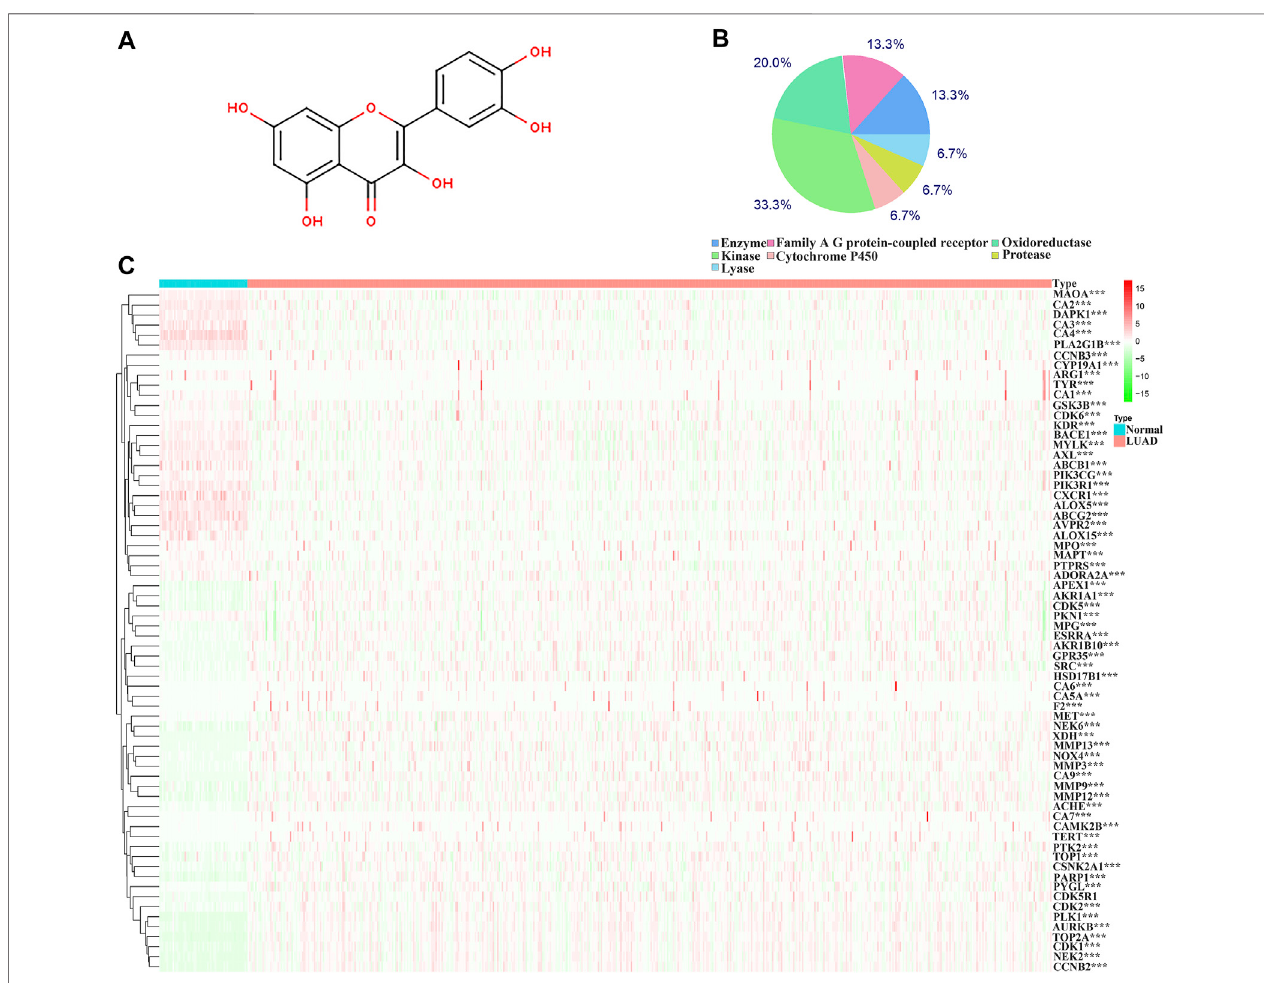
FIGURE1| Structureandtargetgenesofquercetin. (A) Structure; (B) Thedistributionratioofquercetintargetgenes; (C) Quercetin-relateddifferentiallyexpressed genes in TCGA LUAD tissues. Note: TCGA, The Cancer Genome Atlas; LUAD, lung